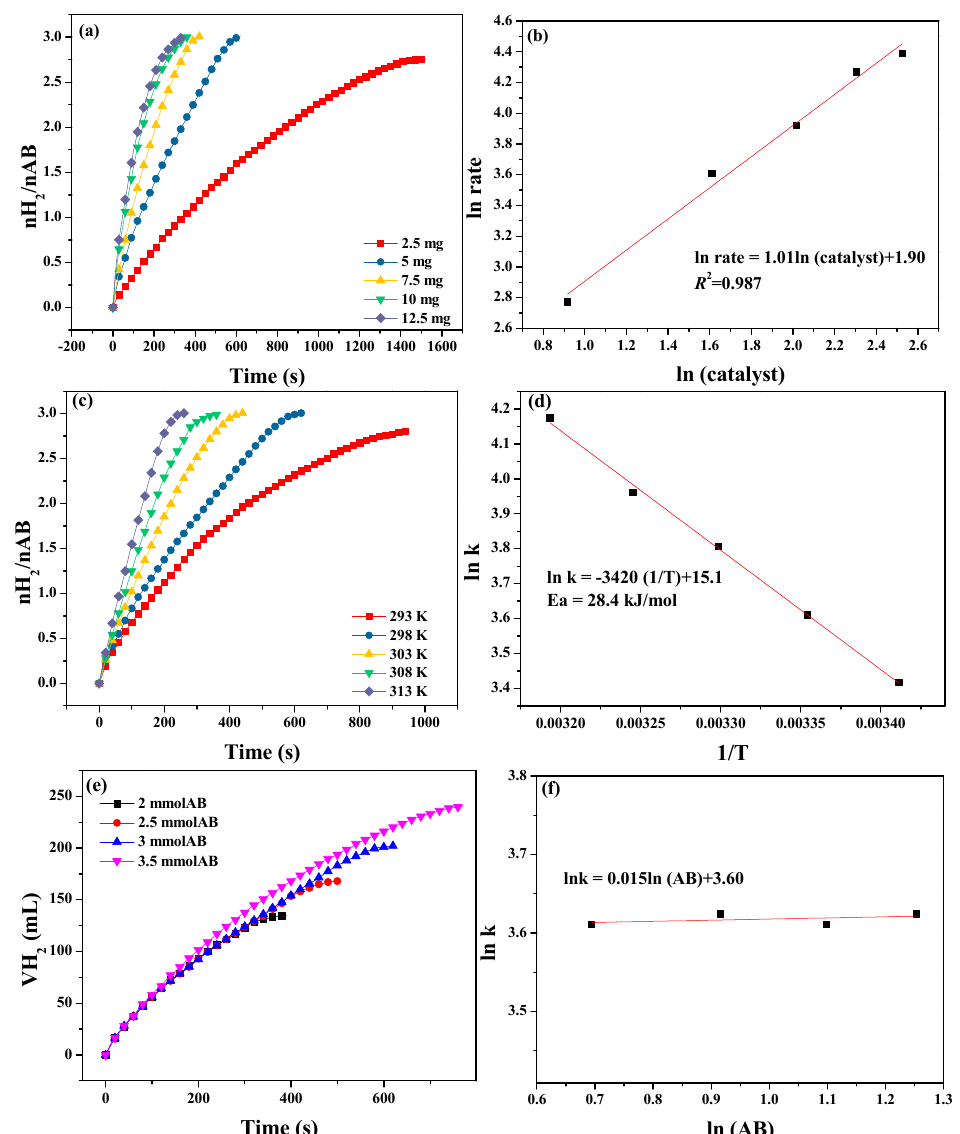
Figure 8. ( a ) Hydrogen evolution at different catalyst dosages (T = 298 K, AB dosage = 3.0 mmol); ( b ) the dependence of the logarithmic values of the hydrogen releasing rate on the logarithmic values of catalyst mass (T = 298 K, AB dosage = 3.0 mmol); ( c ) hydrogen evolution at reaction temperatures of 293–313 K (AB dosage = 3.0 mmol, catalyst weight = 5.0 mg); ( d ) ln k versus 1/T; ( e ) hydrogen evolution at different AB dosages (T = 298 K, catalyst weight = 5.0 mg); and ( f ) the relationship between the logarithmic values of the hydrogen generation rate constant and the logarithmic values of AB dosage.